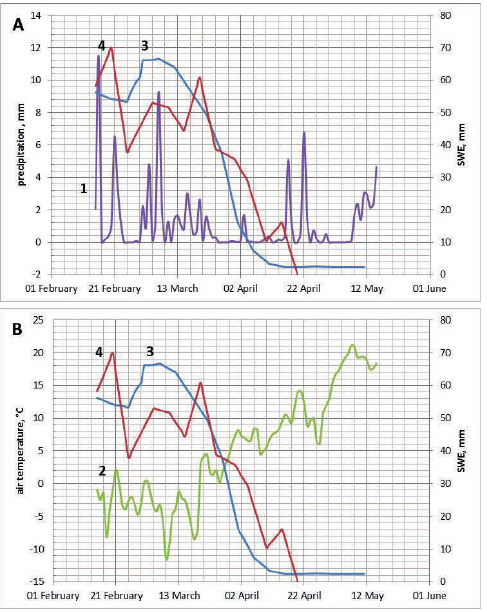
Fig. 2 Comparison of seasonal distributions of SWE and meteorological data for the Don River basin in spring 2010: (А) precipitation, mm, with estimated (2) and in situ (4) SWE; (B) air temperature, ◦C...